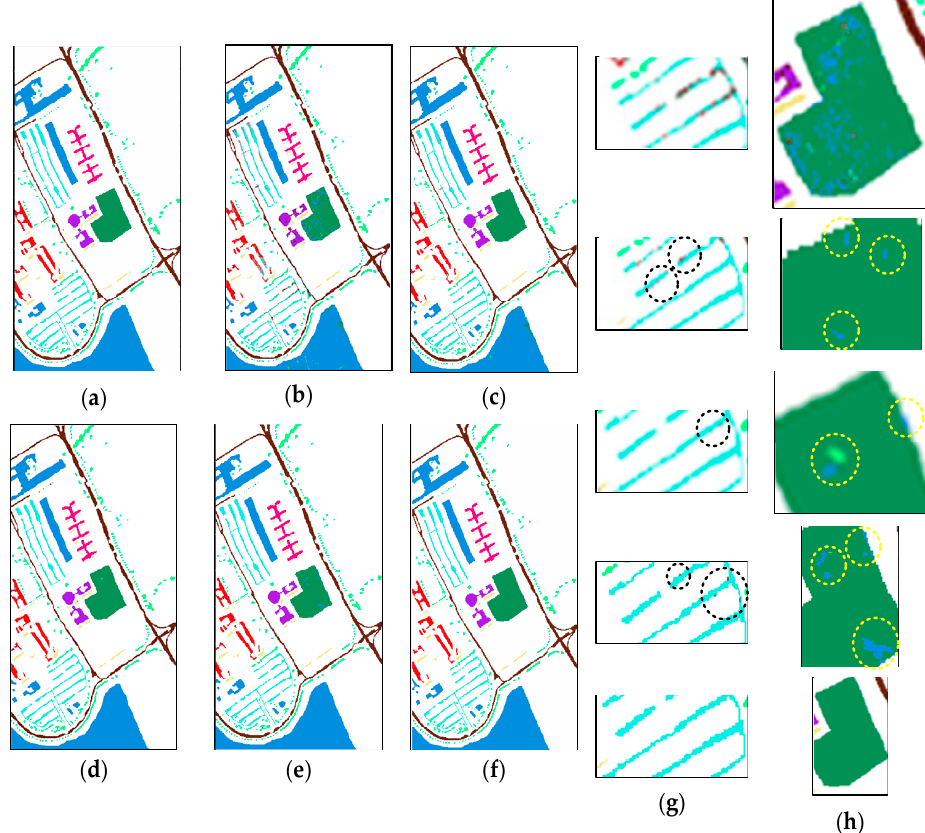
Figure 10. Classification maps from the proposed DANCE-DRCNN method and the baselines on the Pavia University data: ( a ) ground truth; ( b ) SVM-PCA; ( c ) PCA-CNN; ( d ) 3D-CNN; ( e ) DRCNN; ( f ) DANCE-DRCNN; ( g , h ) enlarged edge image. Table 5. Comparison of the classification accuracy (%) among the proposed method, DRCNN, and the baselines on the Indian Pines